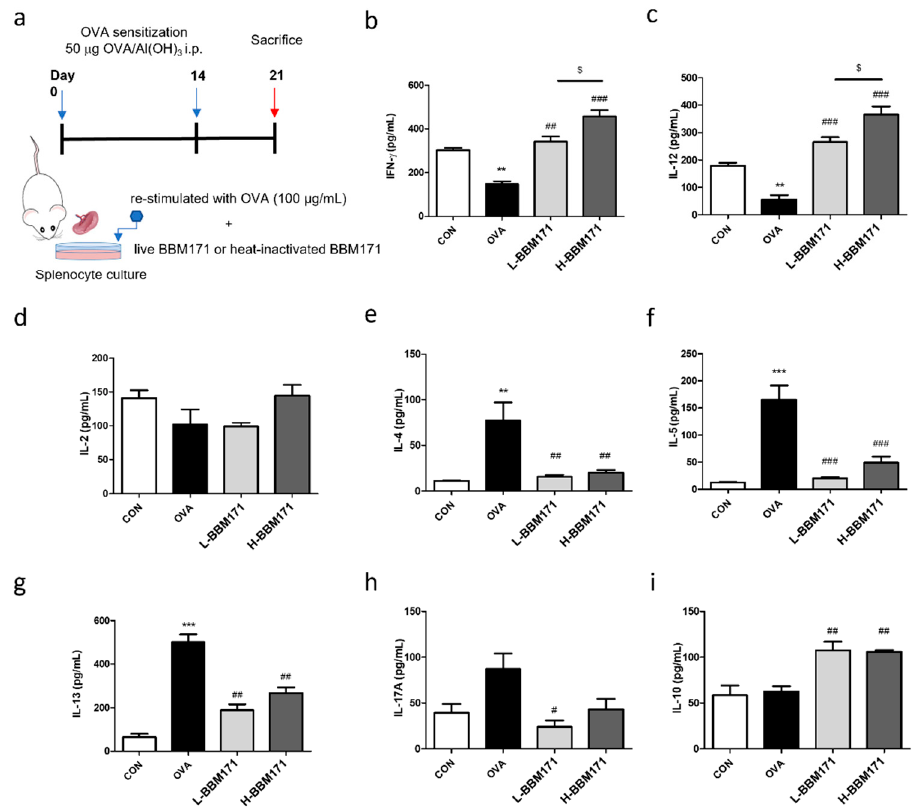
Figure 6. Effects of L. paragasseri BBM171 on T-cell cytokines produced by splenocytes in response to OVA from OVA-sensitized mice. ( a ) The ex vivo study procedure. ( b ) IFN- γ . ( c ) IL-12. ( d ) IL-2. ( e ) IL-4. ( f ) IL-5. ( g ) IL-13. ( h ) IL-17A. ( i ) IL-10. Data are expressed as mean ± SEM and analyzed by one-way ANOVA with Tukey’s post hoc test. Significant differences at ** p < 0.01 and *** p < 0.001 compared with the CON group. # p < 0.05, ## p < 0.01, and ### p < 0.001 compared with the OVA group. $ p < 0.05 between L-BBM171 and H-BBM171 groups.